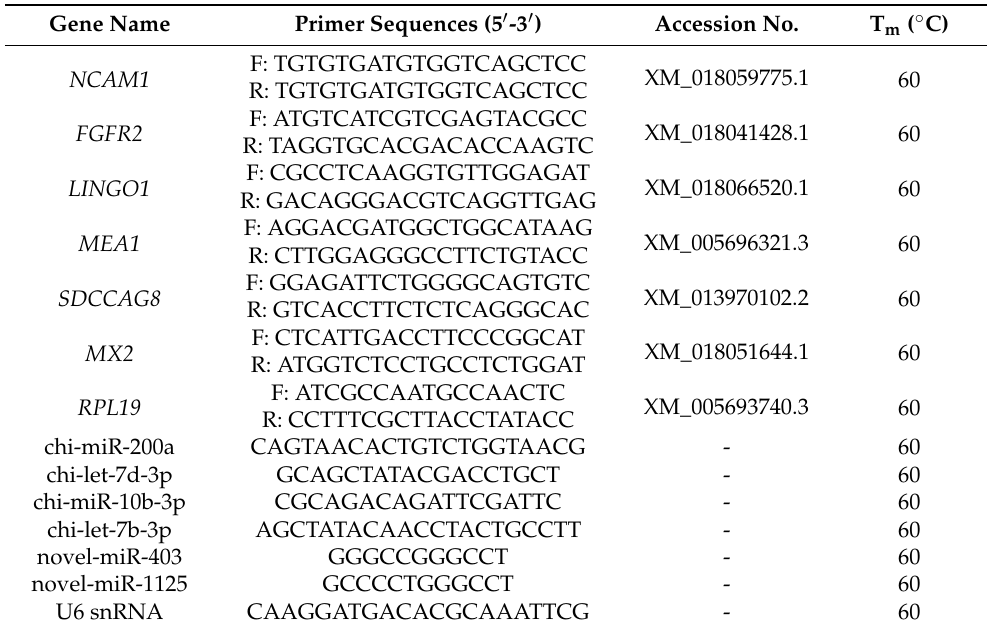
Table 1. The primers of the mRNAs and miRNAs for the